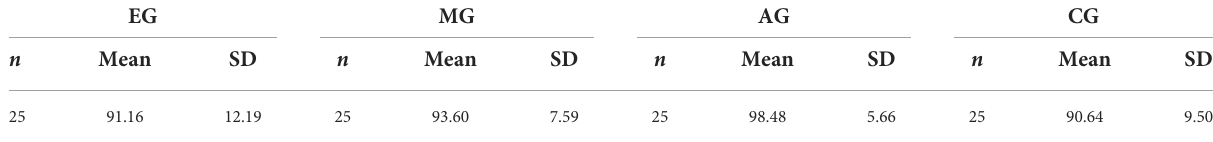
TABLE 1 Descriptive statistics for proficiency